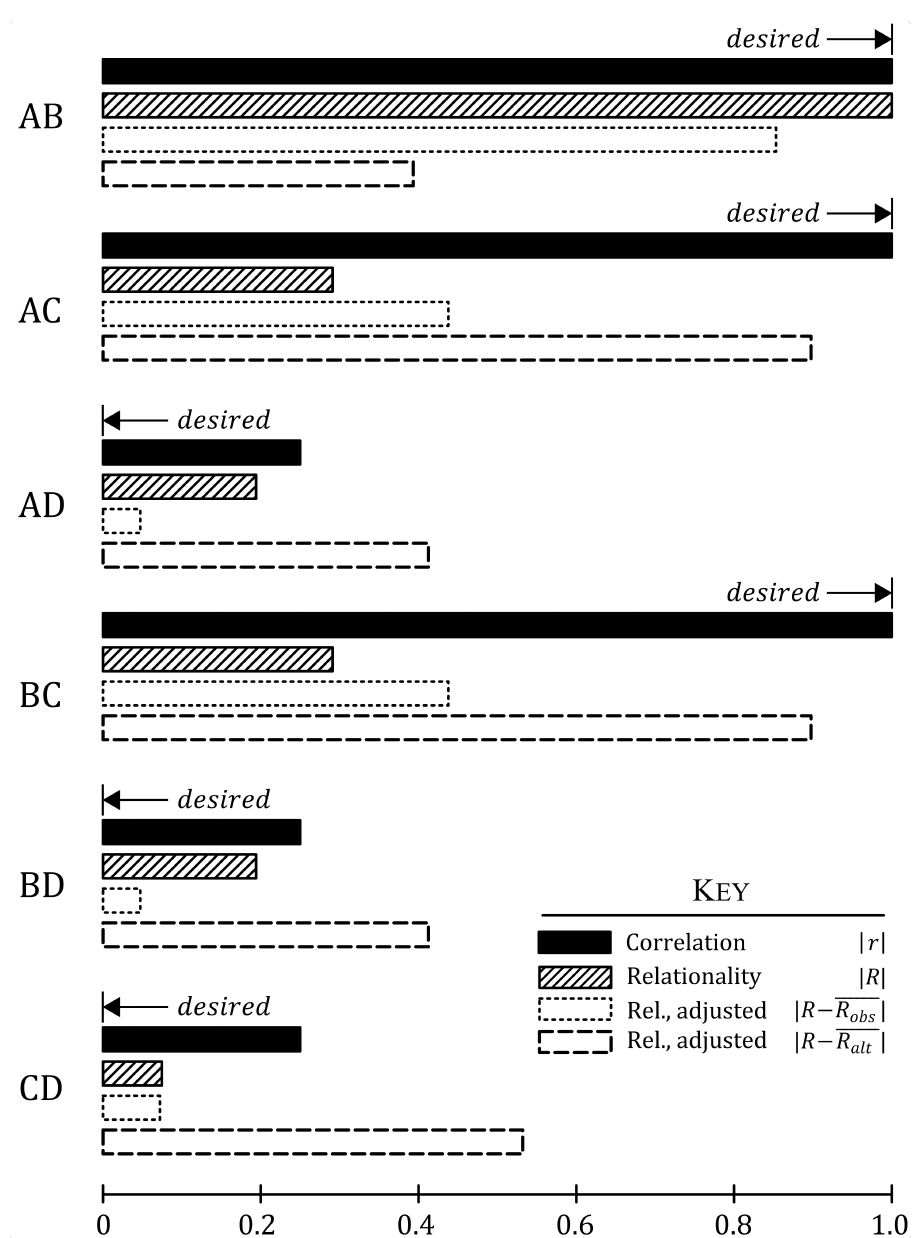
Figure 3: Absolute values of pairwise correlations (solid black) and relationalities (diagonal hatch) among the four response patterns from Figure 1. The goal is to correctly determine that A, B, and C belong to one schematic class but D does not. The desired arrows indicate the values of each comparison that would best lend themselves to this correct answer. The remaining bars depict | R ij | after bias adjustment if each pattern occurs once (dotted) and if patterns A and B occur three additional times